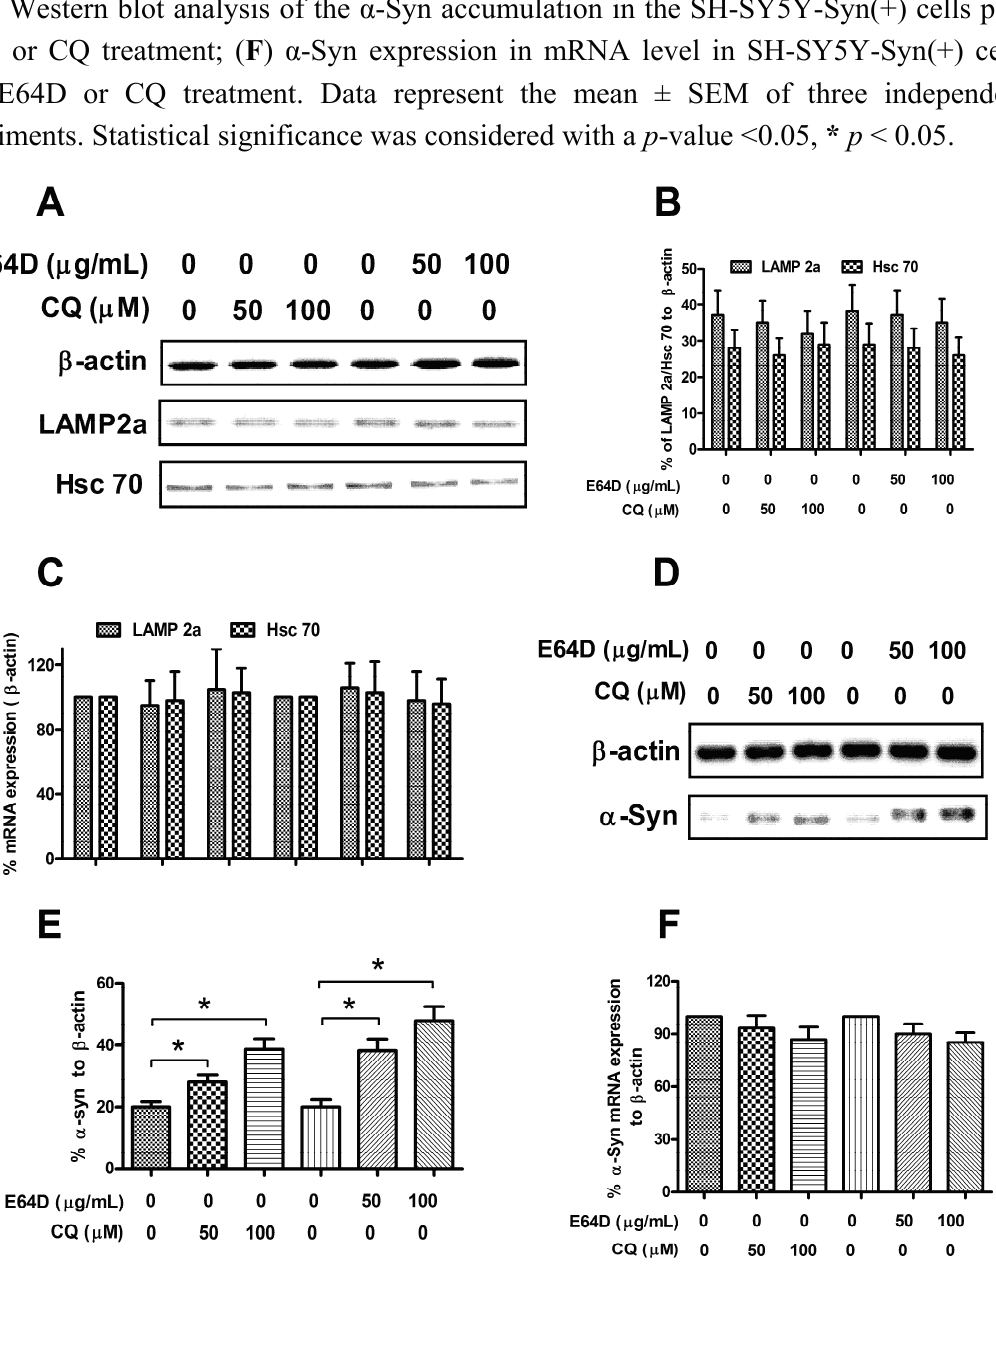
compared to the miRNA control group (either p < 0.001). Moreover, the miRNA-320a mimics transfection could significantly downregulate the α -Syn level in mRNA level ( p < 0.05 for 20 nM and p < 0.01 for 40 nM) (Figure 3C) and in protein level ( p < 0.05 for 20 nM and p < 0.01 for 40 nM)